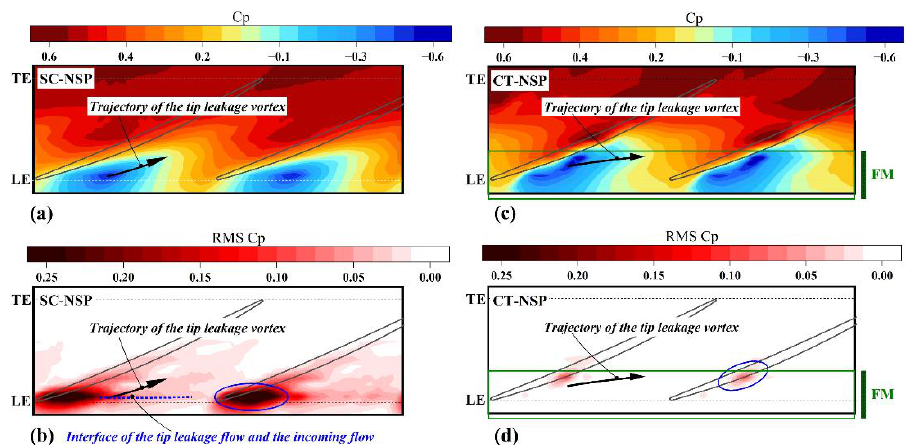
Figure 16. Comparison of tip flow structure of the compressor, with and without casing treatment, at NSP. ( a ) C p contours with SC, ( b ) RMS C p contours with SC, ( c ) C p contours with CT, ( d ) RMS C p contours with CT.